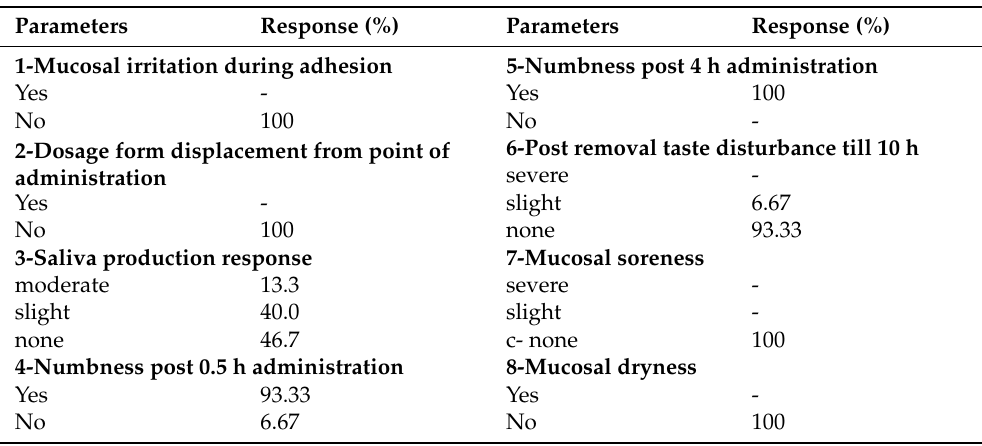
Table 4. Response of human volunteers ( n = 15) to in vivo adaptability for the optimized mucoadhe- sive formulation (F10) in current